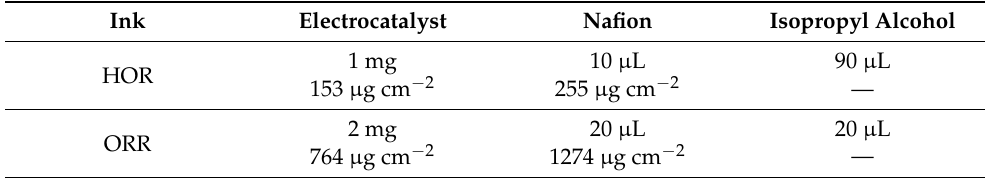
Table 1. Electrocatalyst 30 wt%, Nafion ® 5 wt%, and isopropyl alcohol amounts employed for the ink preparations and their respective